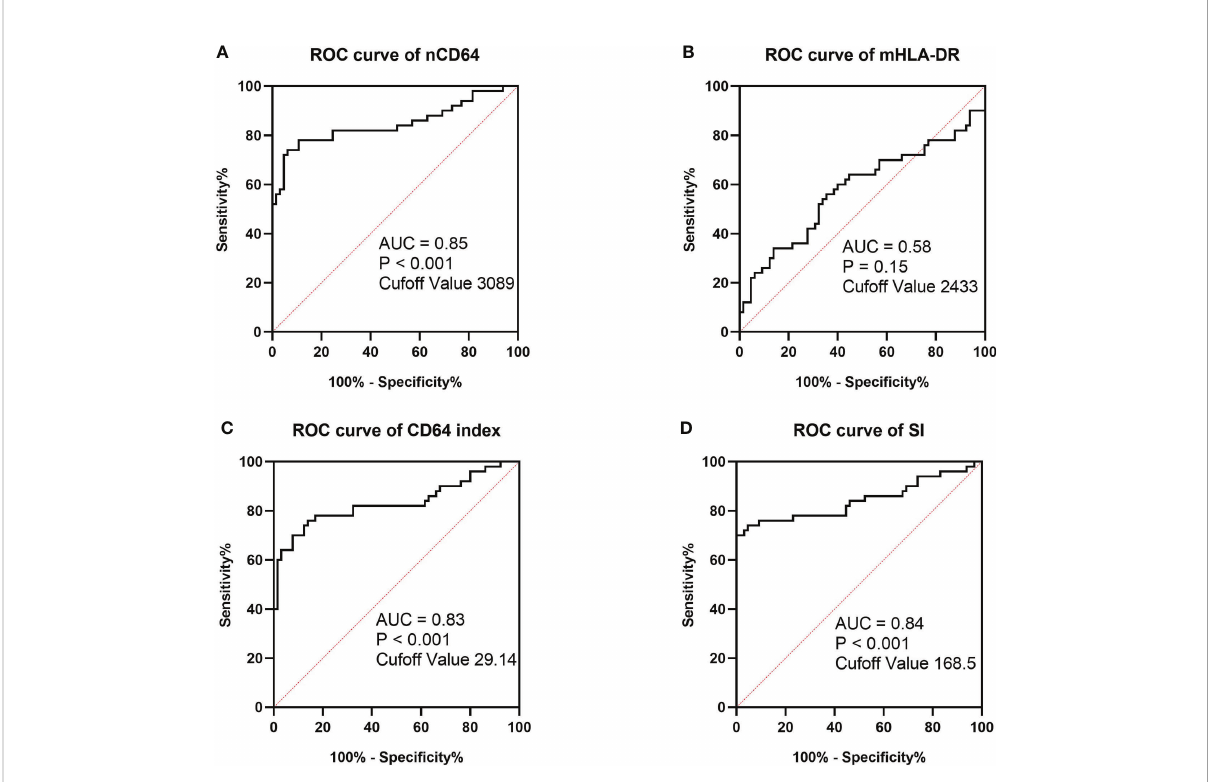
FIGURE 5 ROC curves of MESF of nCD64 (A) , MESF of mHLA-DR (B) , SI (C) and CD64 index (D) for diagnosis of infection in KTRs. The cut-off values were determined by the Youden index. ROC, Receiver operating characteristics; AUC, area under the curve; nCD64, neutrophil CD64; mHLA-DR, monocyte HLA-DR; KTRs, kidney transplant recipients; SI, Sepsis index; MESF, molecules of equivalent soluble fl